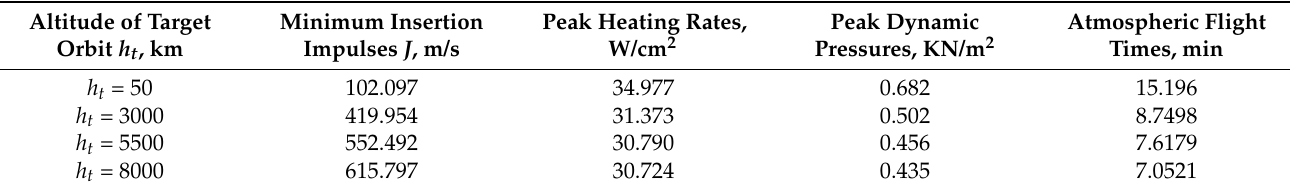
Figure 13. Altitude vs. velocity profiles with different target orbit altitudes. Table 6. Optimal results with different reference area ratios.